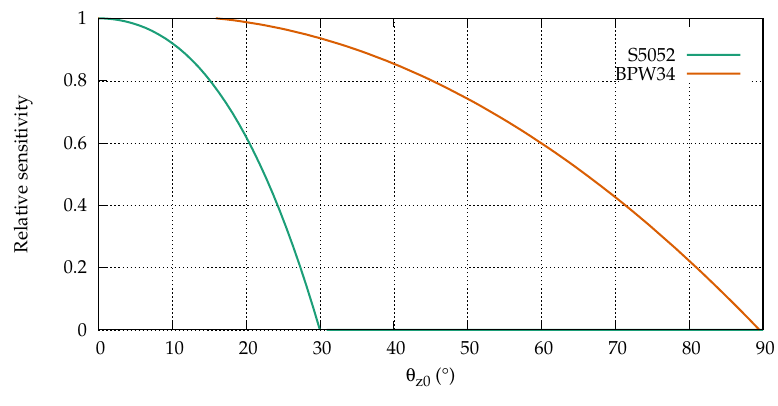
Figure 6. Angular receiver